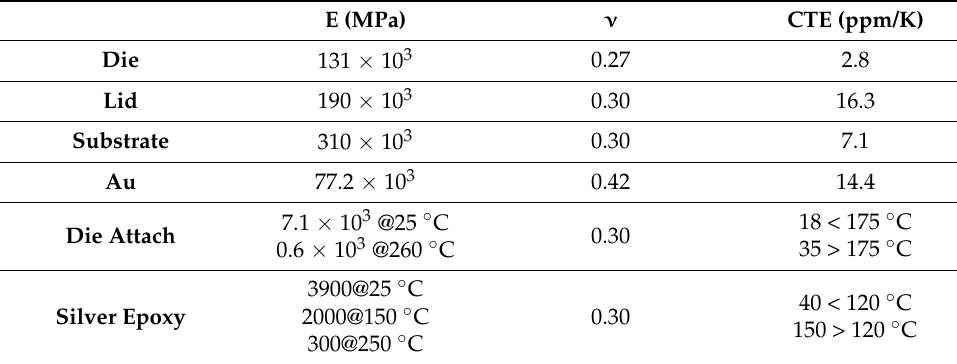
Table 1. The material properties of the finite element model.